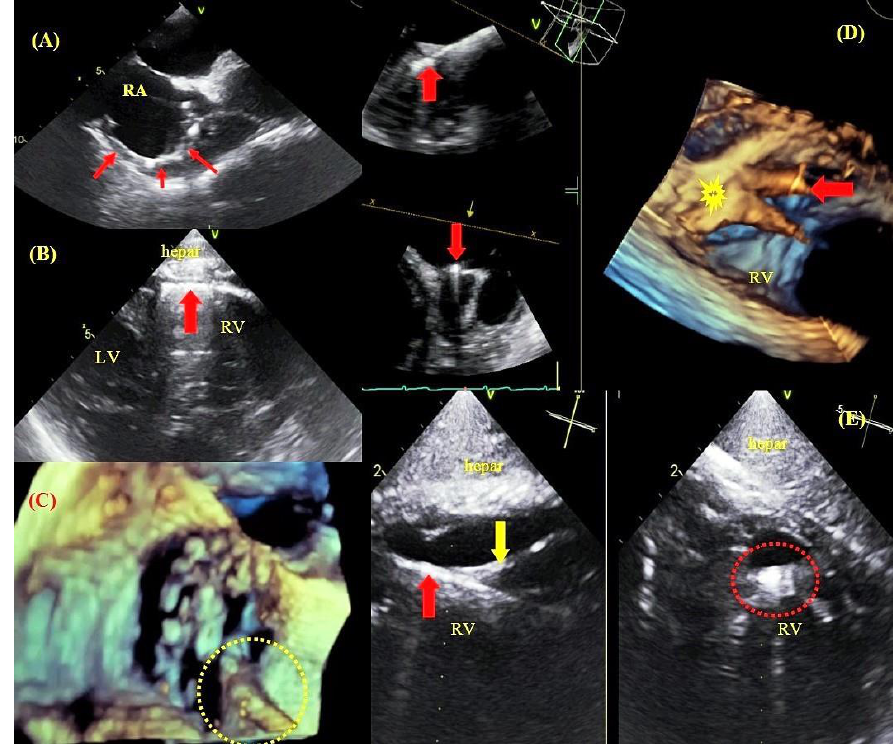
Figure 3. Binding sites between leads and cardiovascular structures visualized by TEE. TEE—bicaval view—a thickened lead (red arrows) adhered to the wall of the right atrium and the superior vena cava orifice ( A ). TEE—transgastric view—a ventricular lead (arrow) adhered to the right ventricular wall ( B ). 3D TEE imaging—the tricuspid valve with a lead adhered to the leaflet margin ( C ). 3D imaging (Multi-D)—a lead (red arrow) implanted at the base of the papillary muscle (yellow arrow) ( D ). TEE (Multi-D)—a ventricular lead (red arrow) adhered to the tendinous thread (yellow arrow) ( E